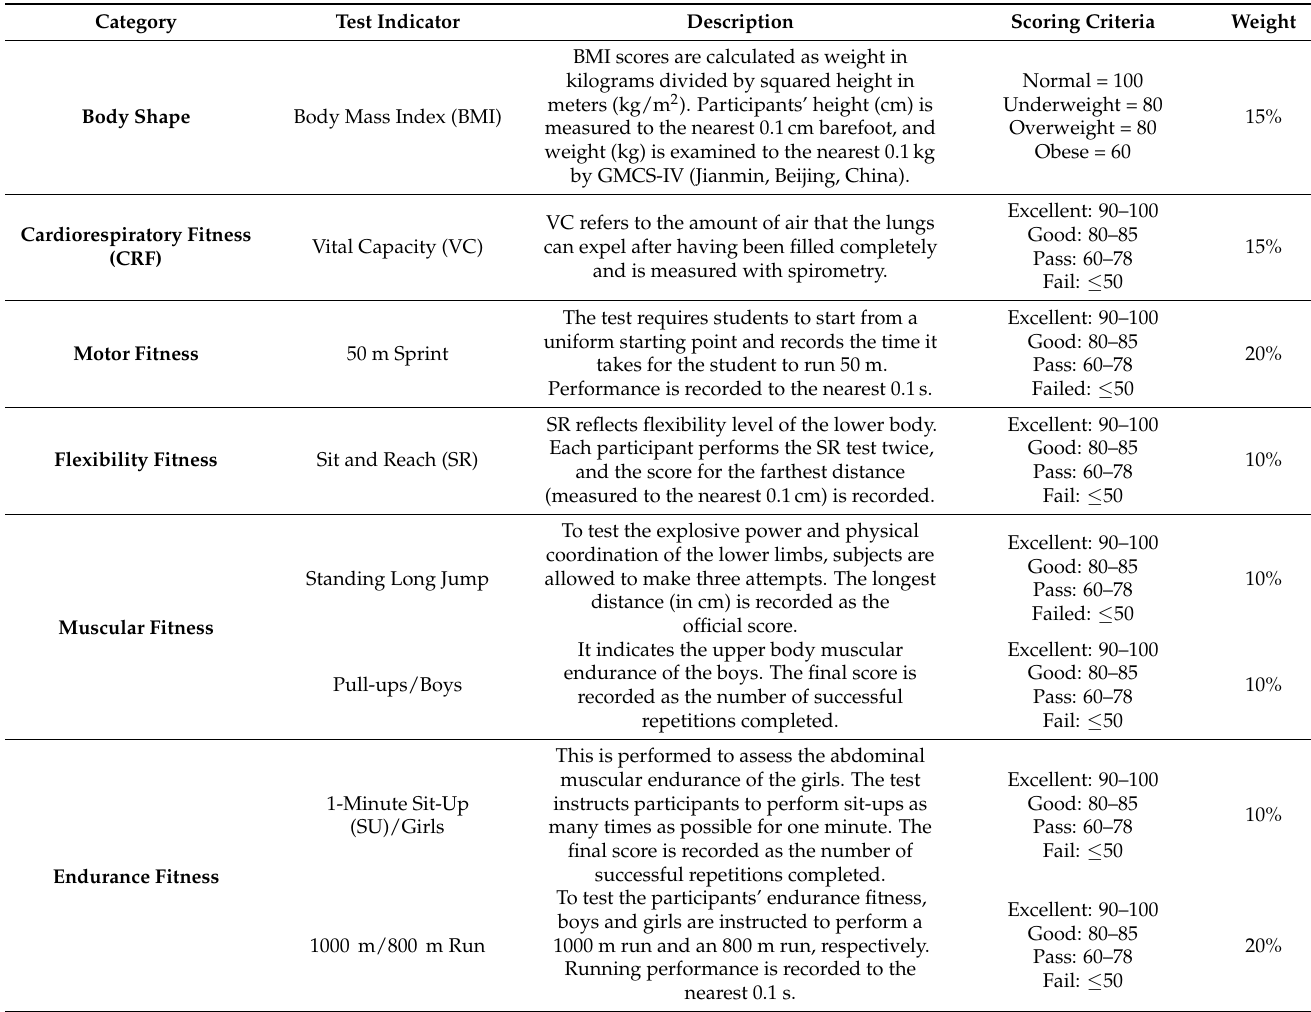
Table 1. Methods and scoring criteria of the physical fitness test for Chinese adolescents and the proportion of scores for each